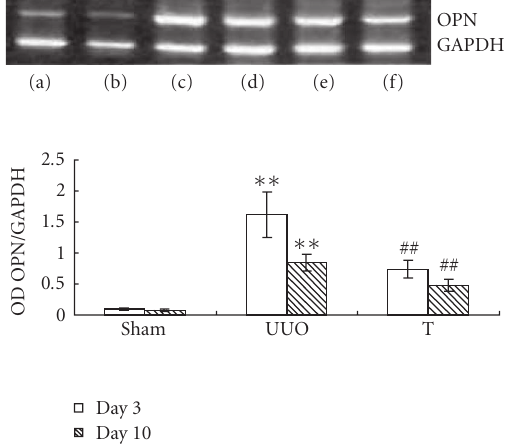
Figure 6: Expression of OPN at di ff erent time points in di ff erent groups by RT-PCR. Total RNA was extracted from kidney tissue at the indicated time and reverse-transcribed to cDNA. cDNA was subject to PCR, and OPN was amplified to 418 bp fragments. GAPDH was used as internal control (a) on day 3 in sham group, (b) on day 10 in sham group, (c) on day 3 in UUO group, (d) on day 10 in UUO group, (e) on day 3 in treatment group, and (f) on day 10 in treatment group. ∗∗ : P < . 01 versus sham group of the same time point. ##: P < . 01 versus UUO group of the same time